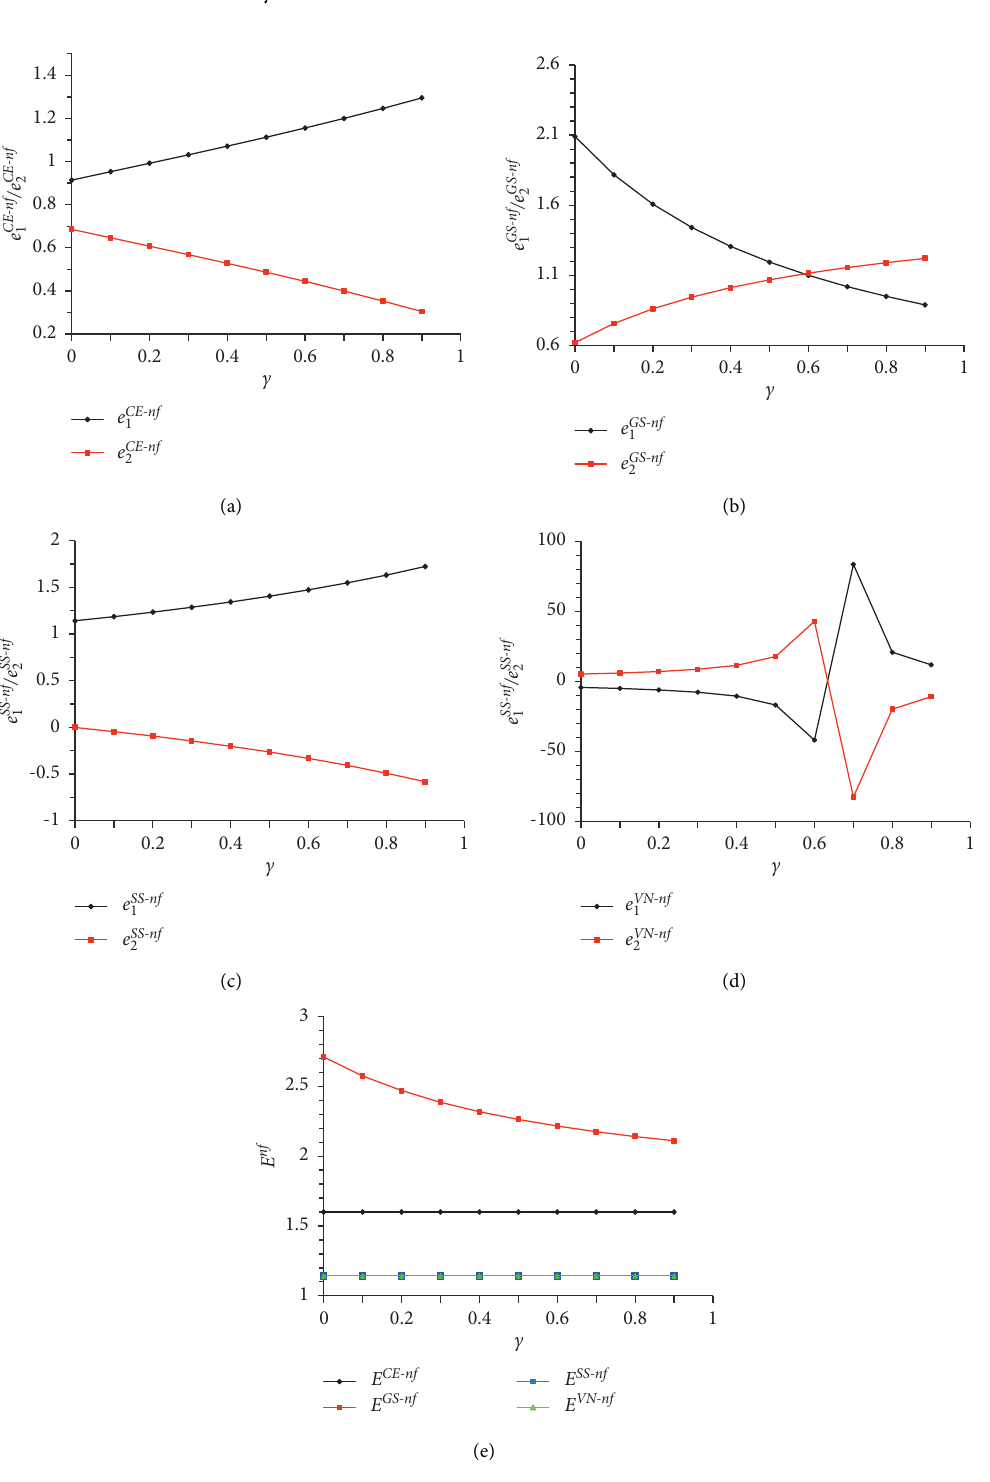
Figure 4: Effects of c on emission reduction